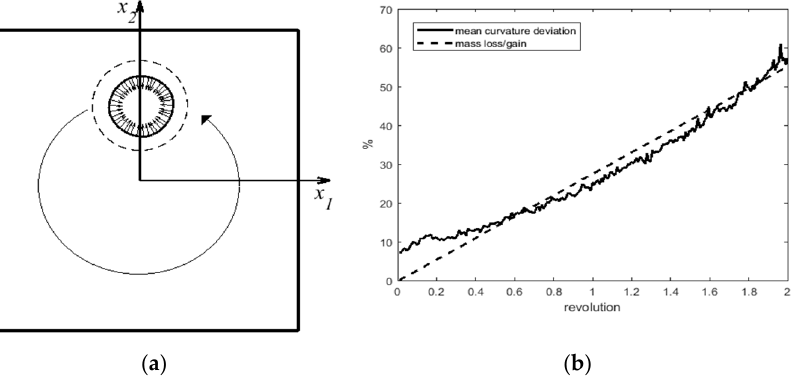
rotates two revolutions around